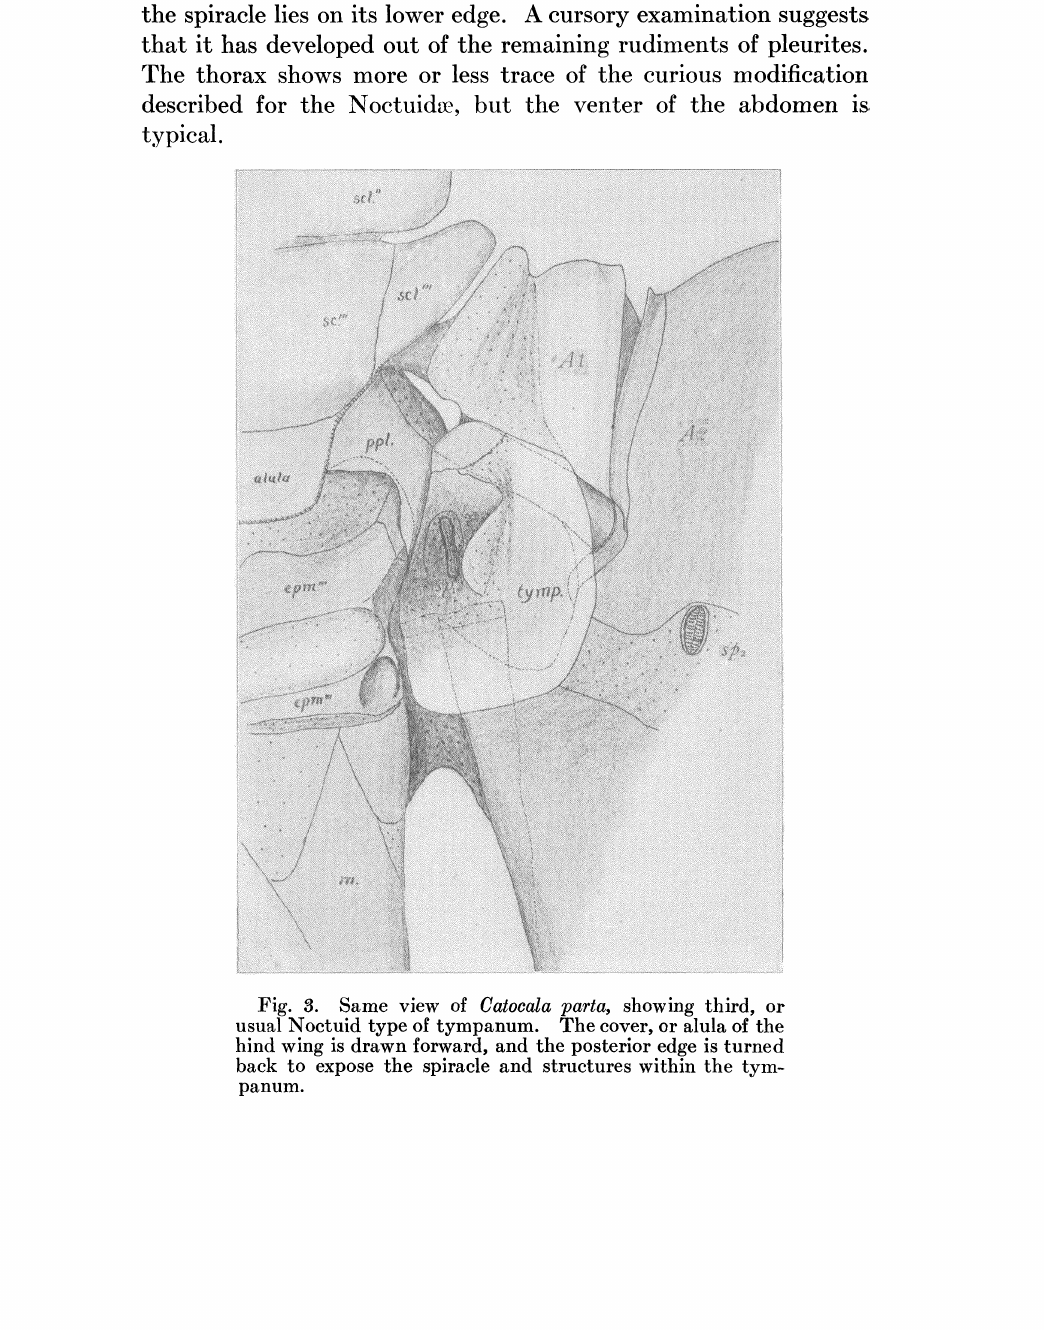
Fig. 8. Same view of Catocala parta, showing third, or usual Noctuid type of tympanum. The cover, or alula of the hind wing is drawn forward, and the posterior edge is turned back to expose the spiracle and structures within the tym-